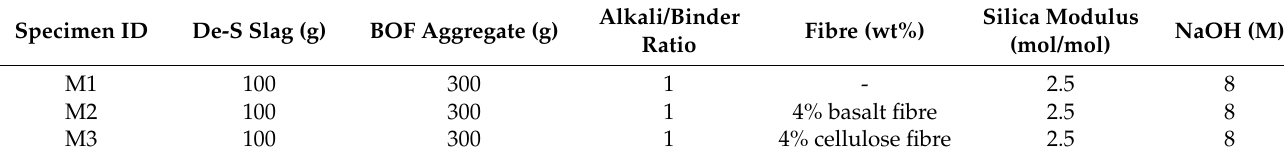
Table 3. Mix recipes of plain mortar (M1) and fiber-reinforced mixtures (M2 and